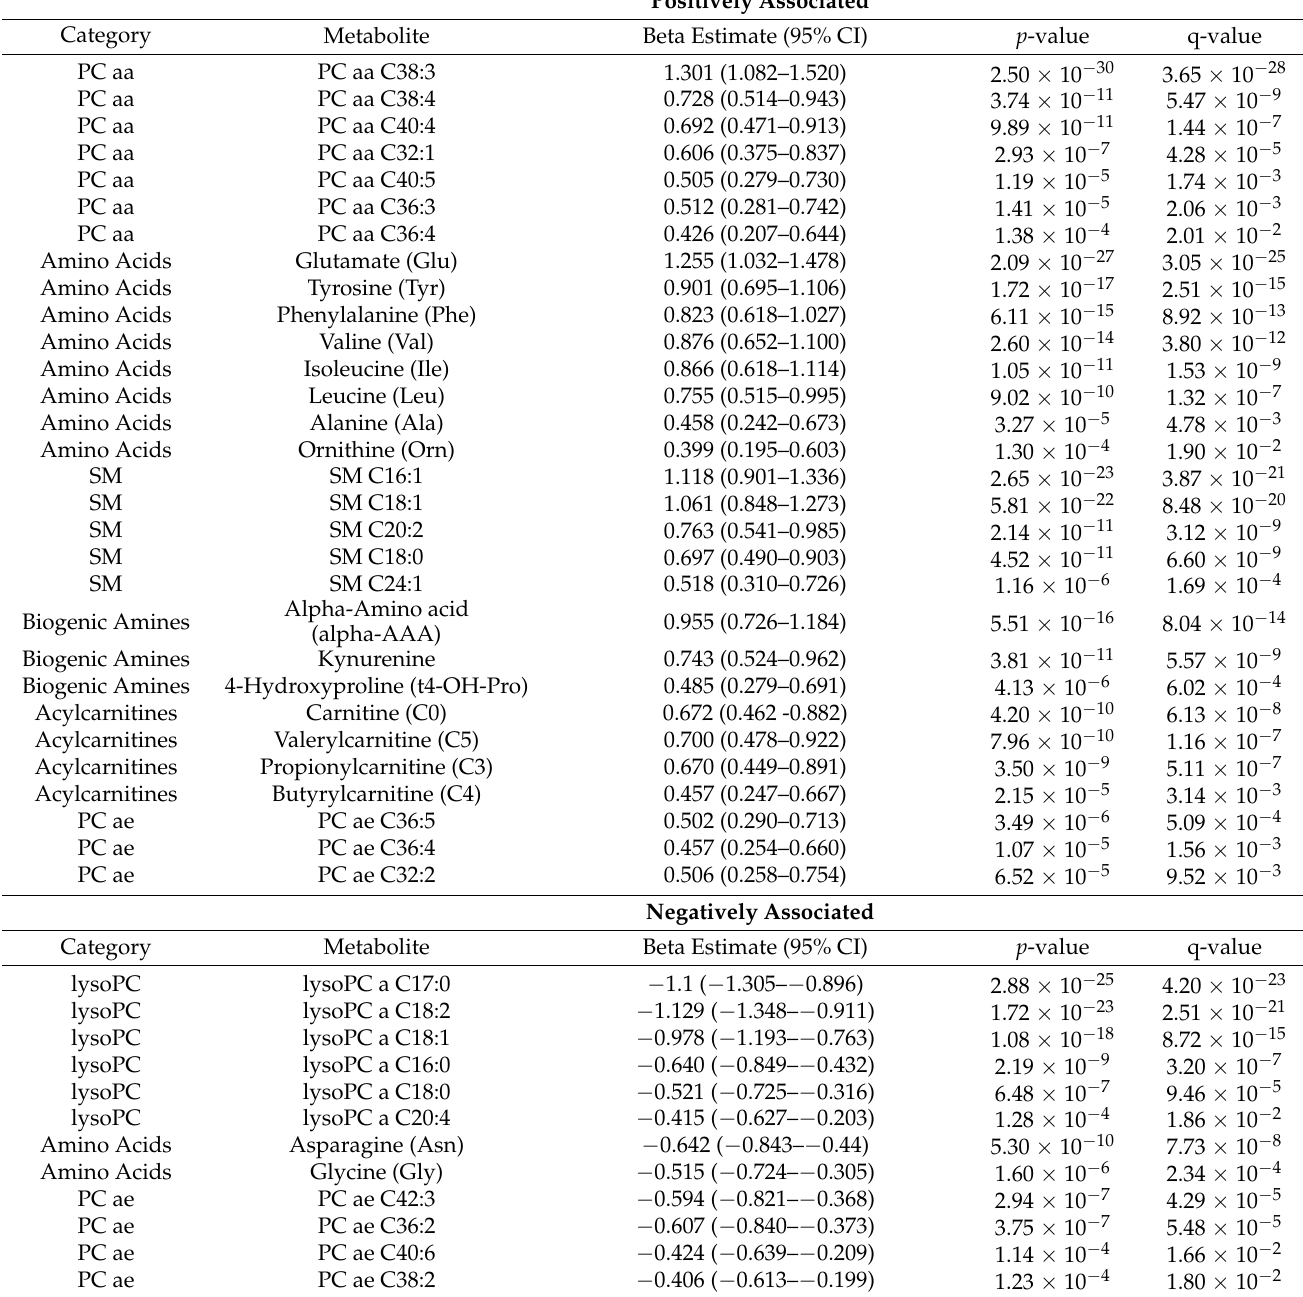
Table 3. Metabolites significantly associated with BMI in the linear regression full model. The dependent variable was BMI, whereas the independent variables were the log transformed and standardized concentration of each metabolite, adjusted for age, sex, smoking status, physical activities, HDL-C, blood pressure, triglycerides, and fasting glucose. q-values were reported as p values adjusted for multiple testing by Bonferroni correction. Only metabolites with a p -value lower than 0.00034 (0.05/146) were included in this